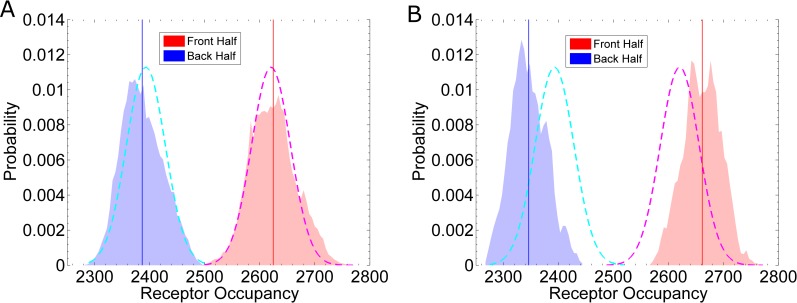
Receptor Diffusion adds Spatial Noise.These curves are similar to those in Fig 4except with slow reaction rates: kon = 1.6×105 (M·s)-1 and koff = 0.0011 s-1. (A) Results from eight simulations. The difference in receptor occupancy is Δn = 238 Ste2*. (B) Results from eight simulations with slow reaction rates and no receptor diffusion; that is, DSte2 = 0 μm2/s. The difference in receptor occupancy is Δn = 315 Ste2*.